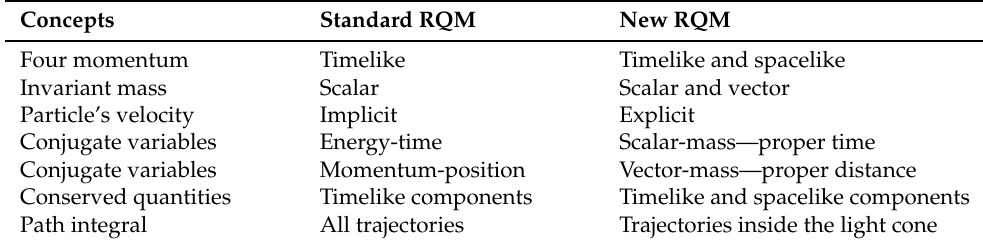
Table 1. Differences between the standard and new